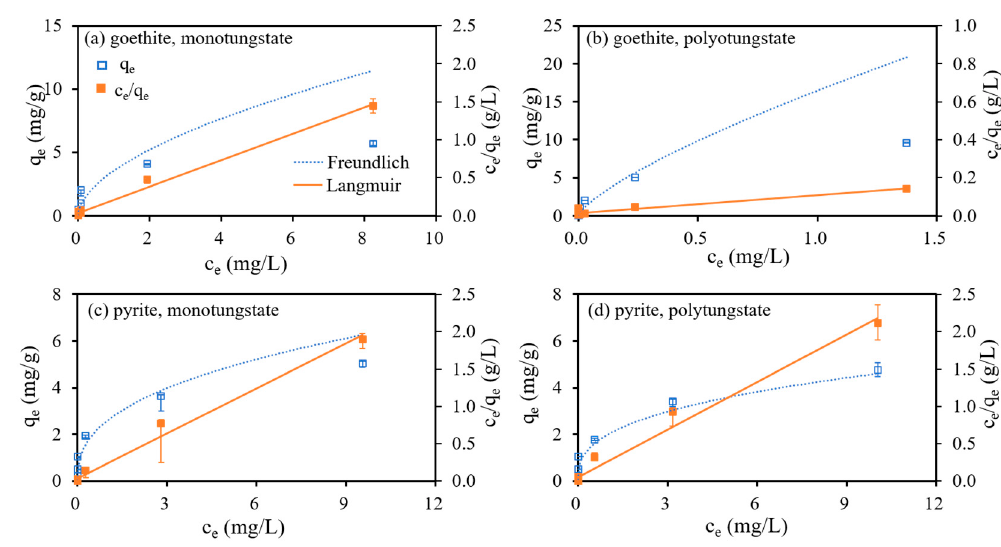
Figure 5. Freundlich and Langmuir isotherm models for monotungstate and polytungstate adsorption onto goethite and pyrite. Table 4. Isotherm constants for tungsten sorption onto goethite and pyrite.